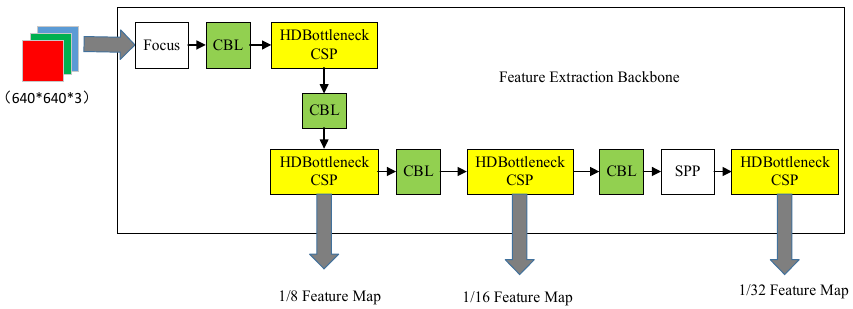
Figure 7. Backbone network structure for feature extraction.